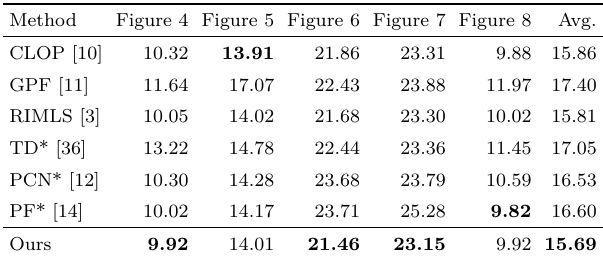
Table 3 Quantitative evaluation of methods on the synthetic point clouds in Figs. 4–8. Deep learning methods are indicated by *. Metric used is MSE ( × 10 − 3 ). The best method for each model is highlighted in